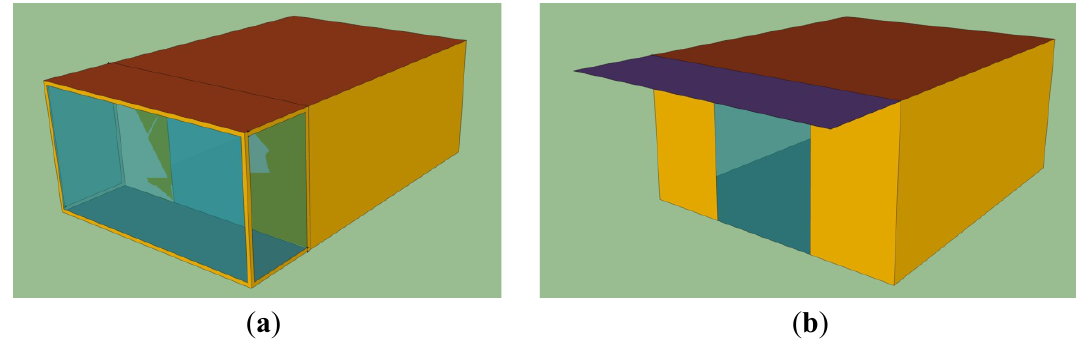
Figure 2. Geometrical model in TRNSYS scenario “0” ( a ) and scenario “1” ( b ).